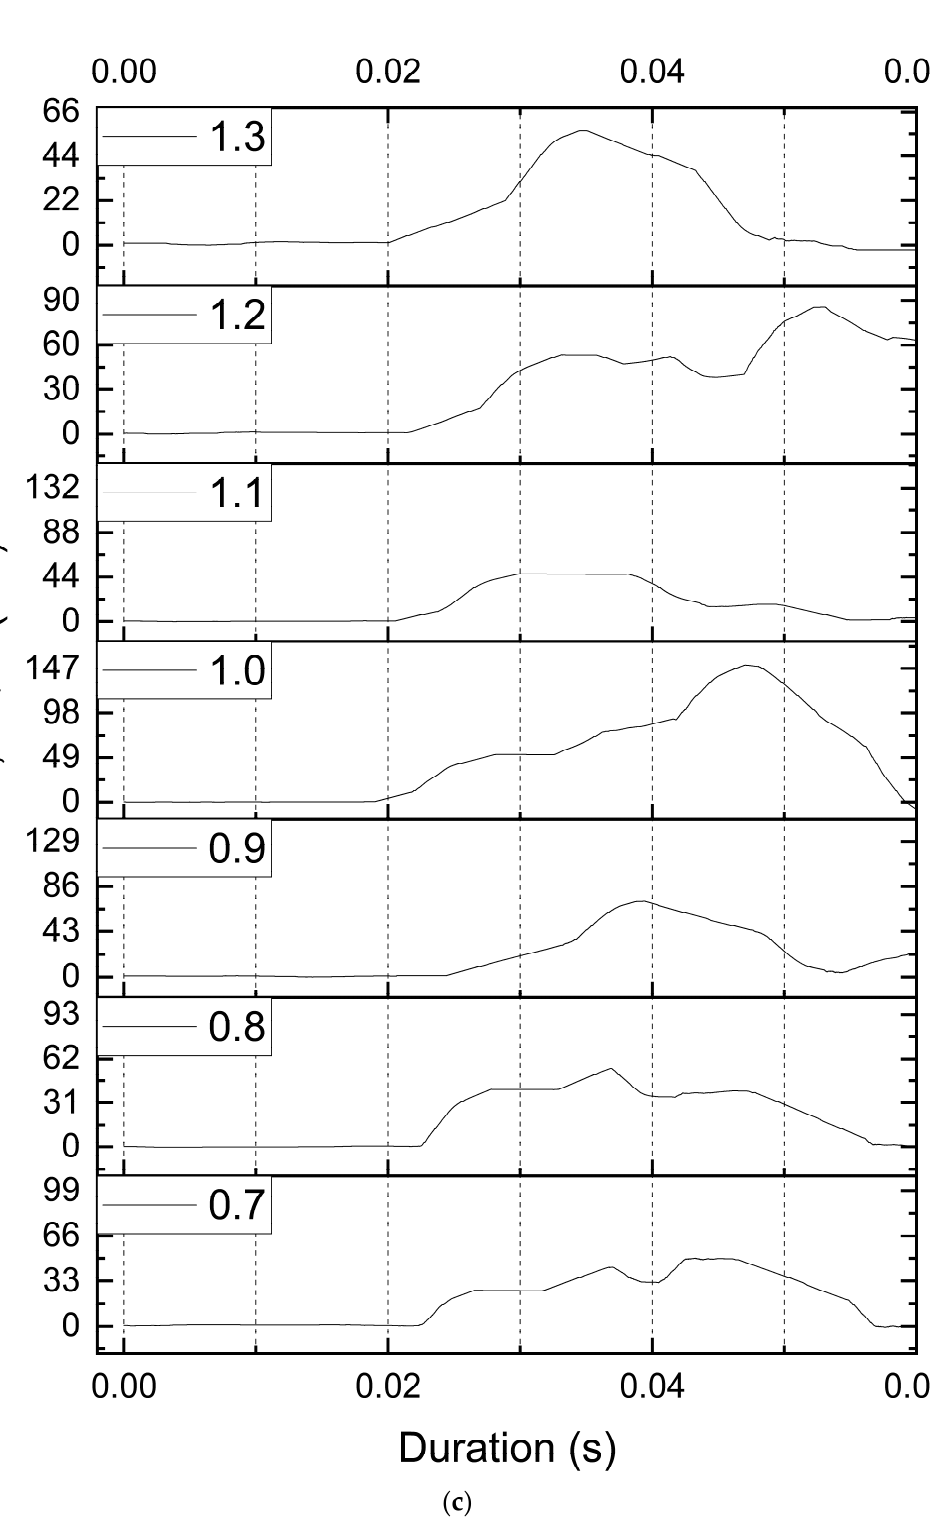
Figure 7. HRRs of different BPGs at 𝜙 from 0.7 to 1.3: ( a ) WP; ( b ) CH; ( c ) PKS.